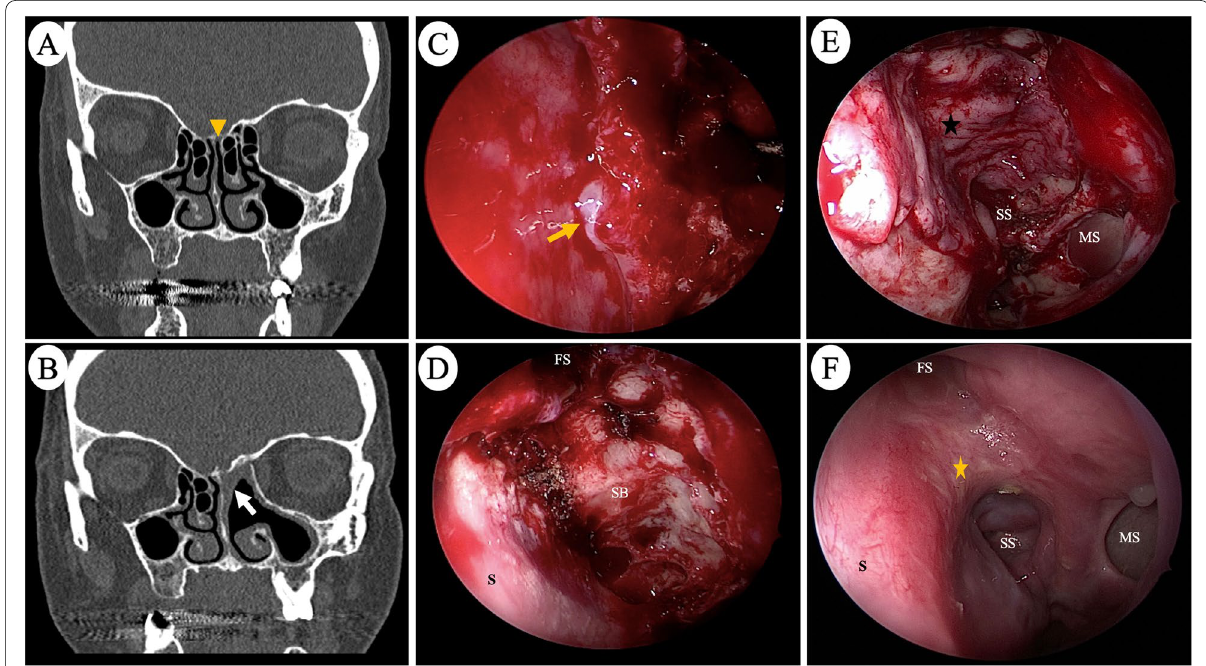
Fig. 1 Illustrate overlay technique. A Pre-operative CT coronal view showing the possible defect site at the left olfactory cleft where denoted by yellow arrowhead. B Postoperative CT scan coronal view noted the defect sealed and marked by white arrow. C Intra-operative endoscopic image showing the defect site marked with yellow arrow. D Intra-operative endoscopic image showing the prepared skull base area denuded of the mucosa and drilled out bony margins. E Intraoperative endoscopic image of draped middle turbine mucoperiosteum as overlay graft denoted by black asterisk. F Postoperative endoscopic image showing the defect repaired and marked by yellow asterisk. SS (sphenoid sinus), MS (maxillary sinus), FS (frontal sinus), S (nasal septum), SB (skull